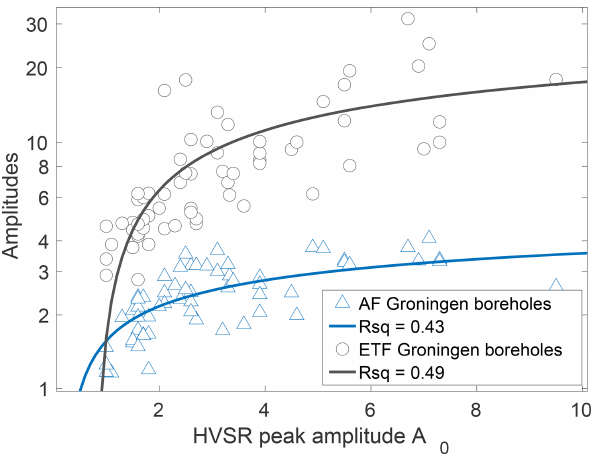
Figure 6. Relation between the HVSR peak amplitudes ( A 0 ) and the ETF peak amplitudes (grey) and the HVSR peak amplitudes and the AF (blue). The solid line represents the fitting function (Eqs. 1 and 2) between the HVSR peak amplitudes and the measured ampli- fication from AF and ETF, respectively. R sq (R-squared) represents the coefficient of determination of the fitting. Note the log-scale of the y